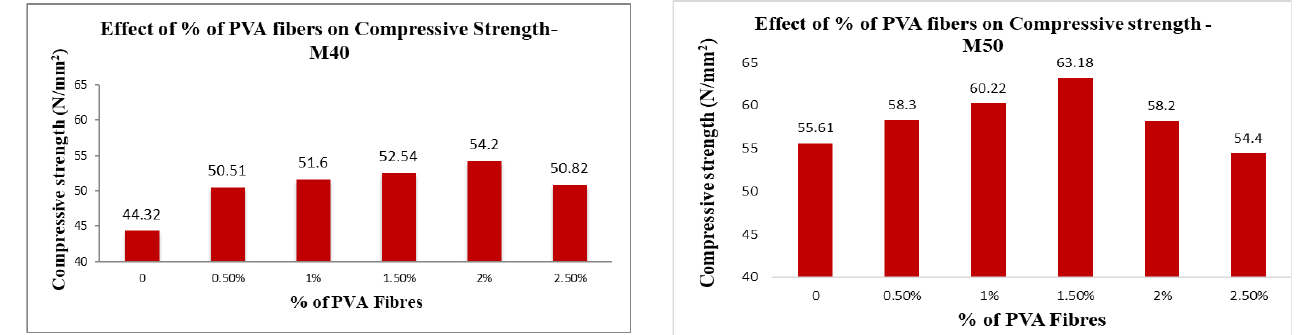
Figure 4. Comparison of compression strength of expansive cement concrete specimen.